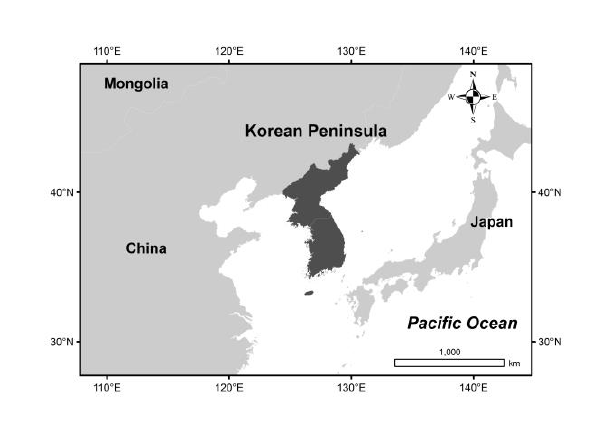
Figure 1. Study area.